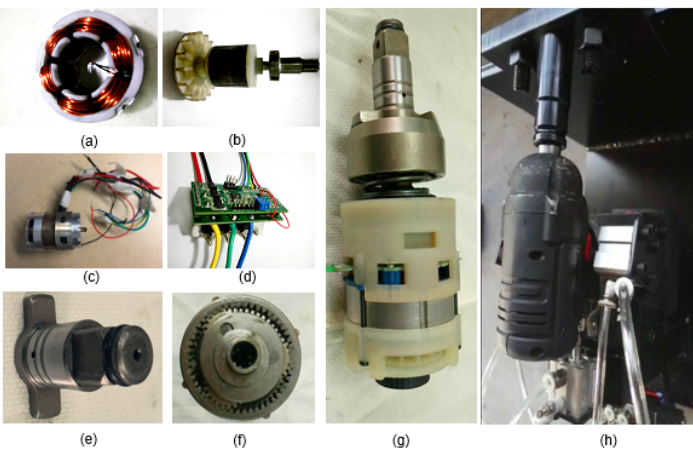
Figure 21. Prototype of IPMBLDC motor for electric impact wrench: ( a ) stator; ( b ) rotor assembled with a shaft, bearing and fan; ( c ) the whole IPMBLDC motor; ( d ) the control board; ( e ) shock block; ( f ) plane gear system; ( g ) the IPMBLDC motor connected with the mechanical system; ( h ) testing